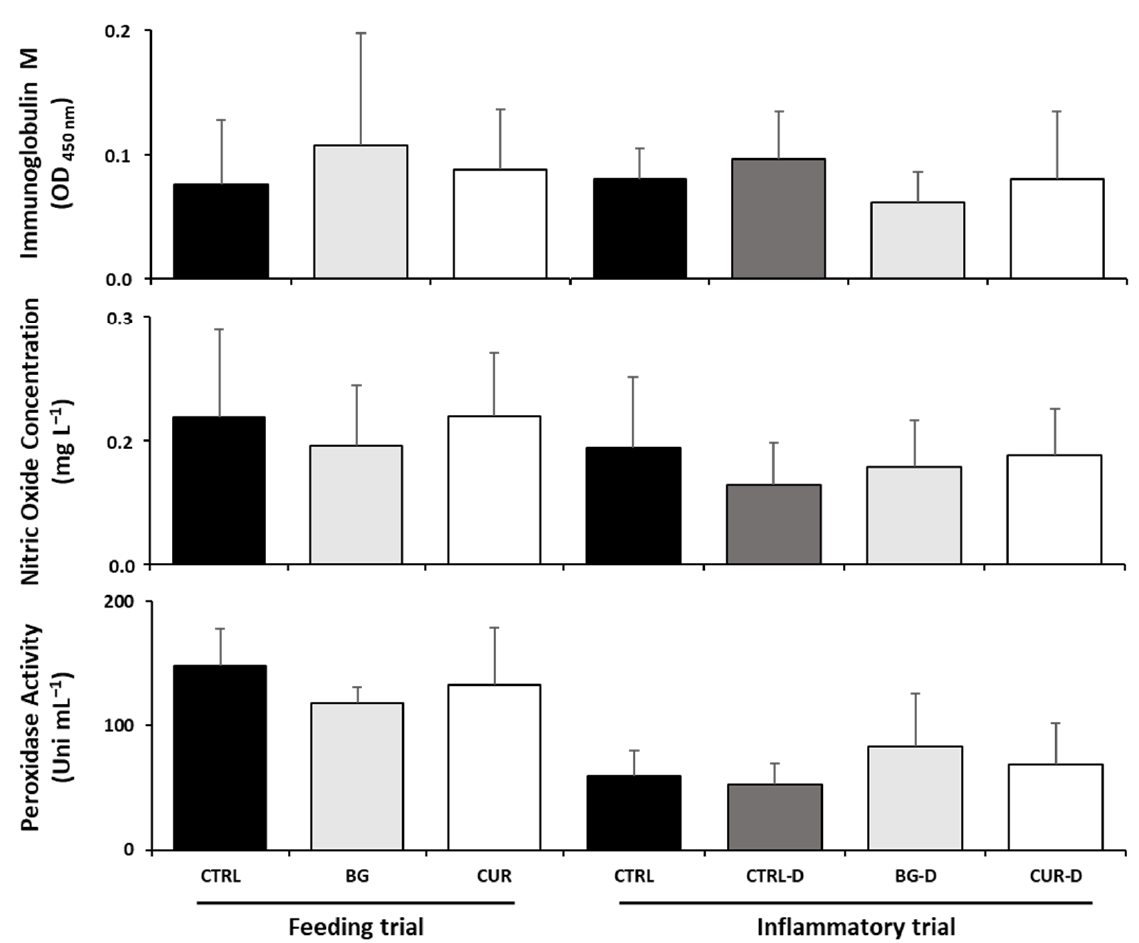
Figure 5. Intestinal humoral immunological parameters of gilthead seabream after the feeding and inflammatory trials ( n = 12). CTRL (control diet), BG ( β -glucans diet), CUR (curcumin diet), CTRL-D (control diet + dextran sodium sulphate − DSS), BG-D ( β -glucans diet + DSS), CUR-D (curcumin diet + DSS).